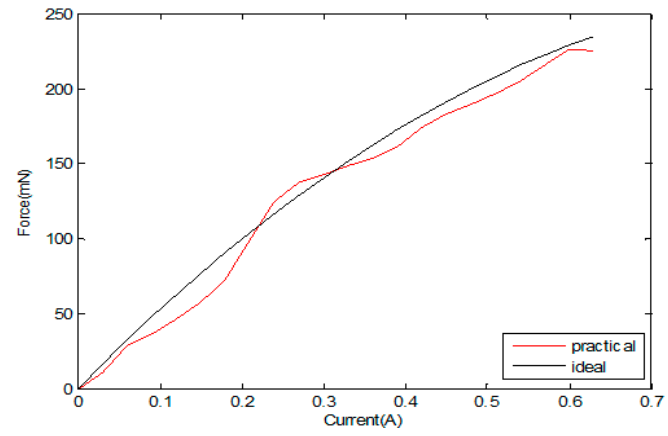
Figure 11. The calibration experiment results for the force and current.